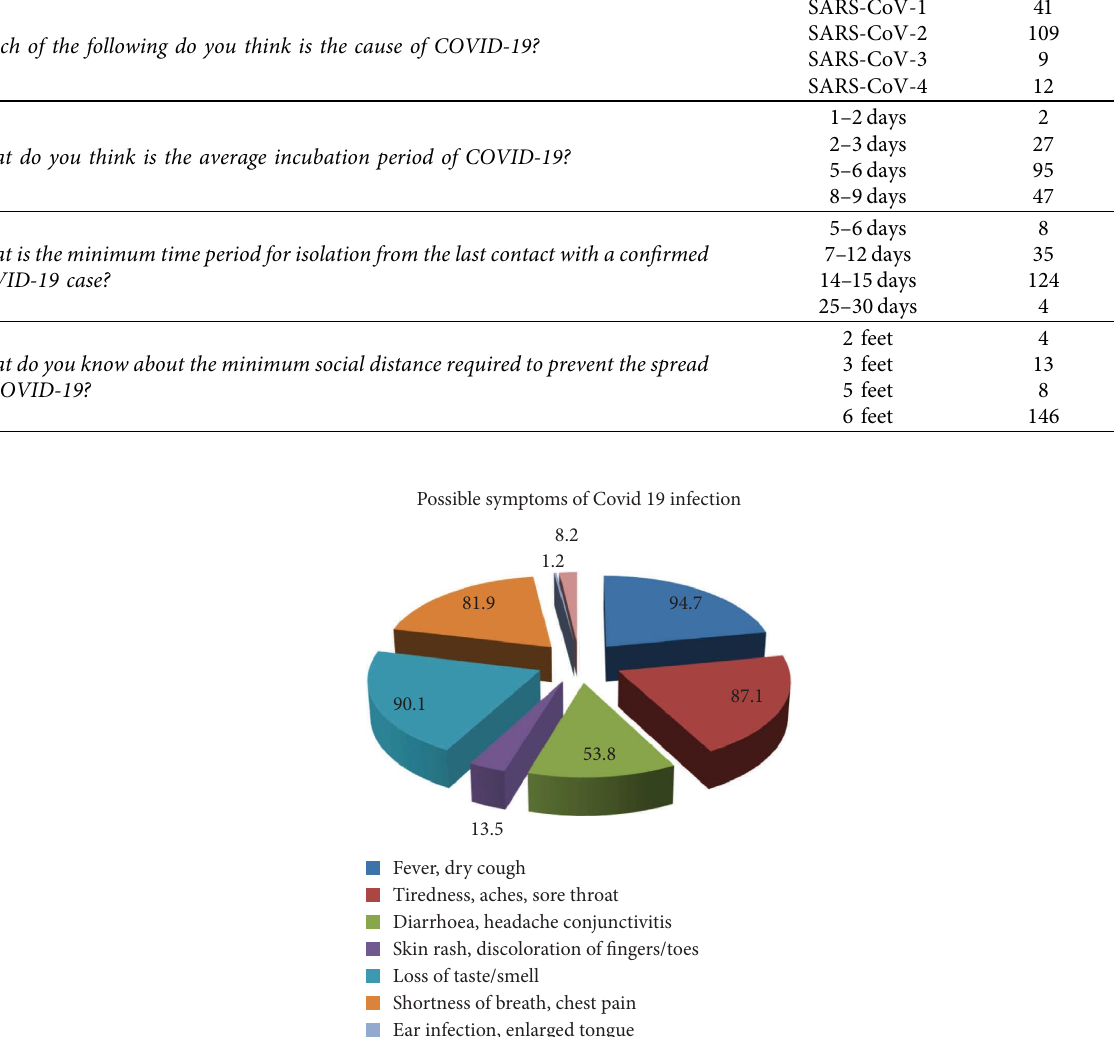
Table 2: Outcomes on the knowledge regarding COVID-19. Questions